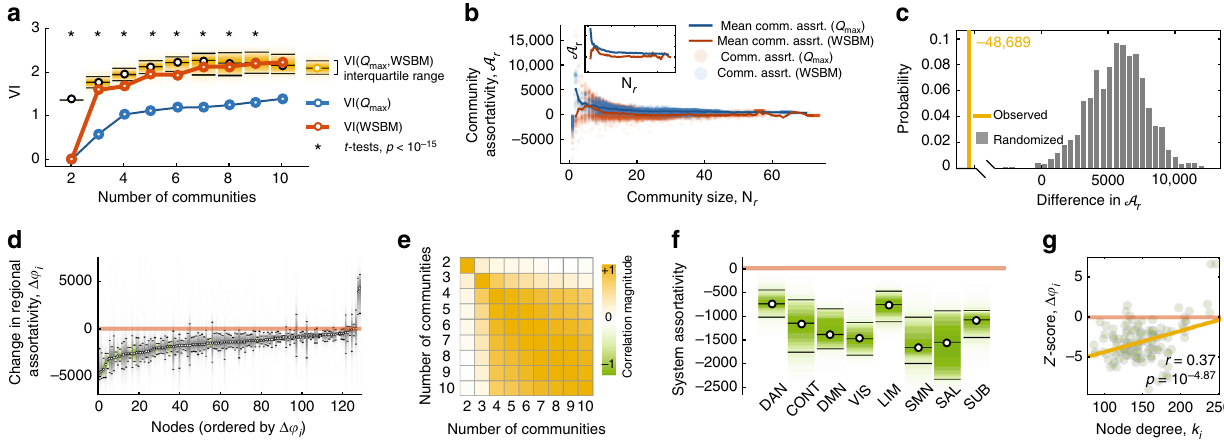
Fig. 3 Modularity maximization and the weighted stochastic blockmodel uncover fundamentally different architectural signatures. a Variation of information within and across community detection techniques ( Q max and WSBM) demonstrating greater dissimilarity of partitions between techniques than within techniques. b Community assortativity, A , as a function of community size, N , demonstrating that Q max communities, on average, are more assortative (the inset shows the mean community assortativity curves as a function of distance). Note: asterisks indicate that both t tests were statistically signi fi cant. c Comparison of statistic derived using functional data analysis (yellow line) with that expected in a null distribution. Speci fi cally, we generated a statistic by performing a pointwise subtraction and summation of the curves Að N Þ obtained for the WSBM and Q max . The value of this statistic quanti fi es the difference between mean community assortativity across communities of all sizes and is negative when communities detected using Q max are more assortative than WSBMs. We compared this statistic against a null distribution obtained from a null model wherein we preserved the number and size of communities in a given partition but permute nodes ’ assignments uniformly and randomly (1000 repetitions). d Changes in regional assortativity, Δ a i , when considering WSBM versus Q max partitions, ordered by greatest to least decrease. Note that the majority of regions decrease assortativity in the partitions estimated from WSBM compared to those estimated from Q max (i.e., Δ ϕ i < 0). e Correlation of regional assortativity while varying the number of communities from K = 2, … ,10. Note the high consistency for K ≥ 4. f Regional assortativity scores grouped by cognitive systems: DAN, dorsal attention; CONT, cognitive control; DMN, default mode; VIS, visual; LIM, limbic; SMN, somatomotor; SAL, salience; SUB, subcortical. The limits of each box represent the interquartile range (25th and 75th percentiles). g Regional assortativity (corrected for degree through standardization procedure) as a function of